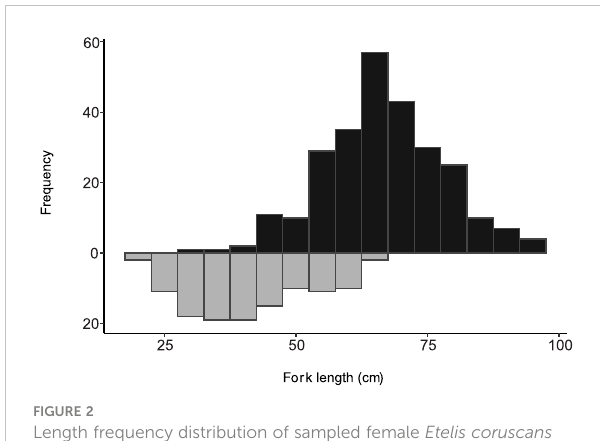
FIGURE 2 Length frequency distribution of sampled female Etelis coruscans collected during October 2007 to December 2020, from the main Hawaiian Islands, in 5-cm size bins. The black bars above the x-axis indicate the range in sizes of physiologically mature individuals and the grey bars below the x-axis indicate range in sizes of immature